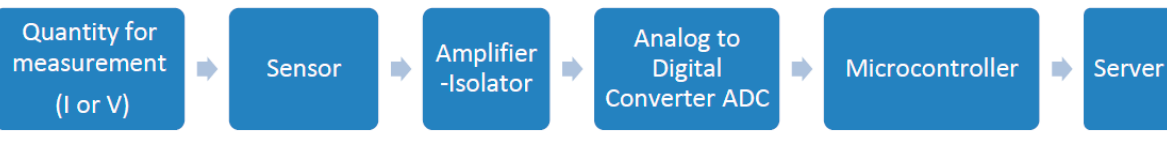
Figure 8. Experimental System (details): Voltage and current data acquisition unit, with opto-isolator Hall sensor and SBM2: ( a ) front side of module; and ( b ) backside of module.